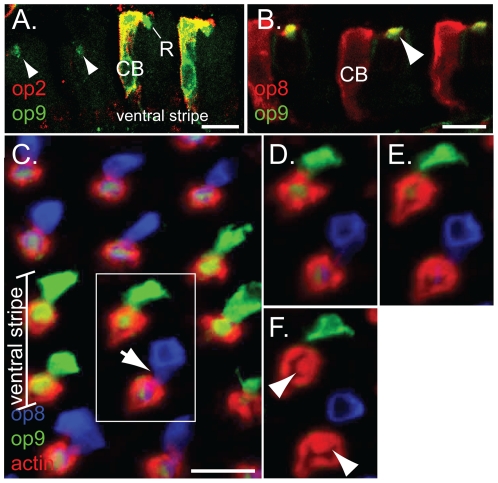
Aaop9 rhodopsin expression pattern in the ommatidia of central, ventral stripe, and ventral regions.A. An Ae. aegypti retinal section including the ventral stripe showing longitudinal views of Aaop2-expressing R7 cells (red). These cells also express Aaop9 (green) within the cell body (CB) and rhabdomere (R). Aaop9 is also weakly detected at discrete sites in the central region (arrowheads). These sites are documented in Fig. 3B to be R7 cell rhabdomeres. The double labeling was carried out using a mouse Aaop9 antibody as described in Materials and Methods. All scale bars are ∼10 µm. B. A retinal section of Ae. aegypti showing longitudinal views of Aaop8-expressing R7 cells (red) in the central region. Aaop9 (green) is localized to the rhabdomere of these R7 cells. C. Aaop8, Aaop9, and actin localization in x, y confocal microscope views of whole mounted retina in the ventral stripe region. The boxed region shows ommatidia viewed at a depth of the R7 rhabdomere (furthest distal), deduced from the presence of a stalk (arrow) connecting the R7 cell body to the rhabdom. D, E, F. Additional x, y optical sections of the two ommatidia boxed in C. These sections are 1 µm above, 1 µm below, and 3 µm below, respectively, of the section displayed in C. Aaop9 is not detected in the proximal section (F) that shows the R8 rhabdomere (arrowheads) as well as the outer (R1–6) rhabdomeres.